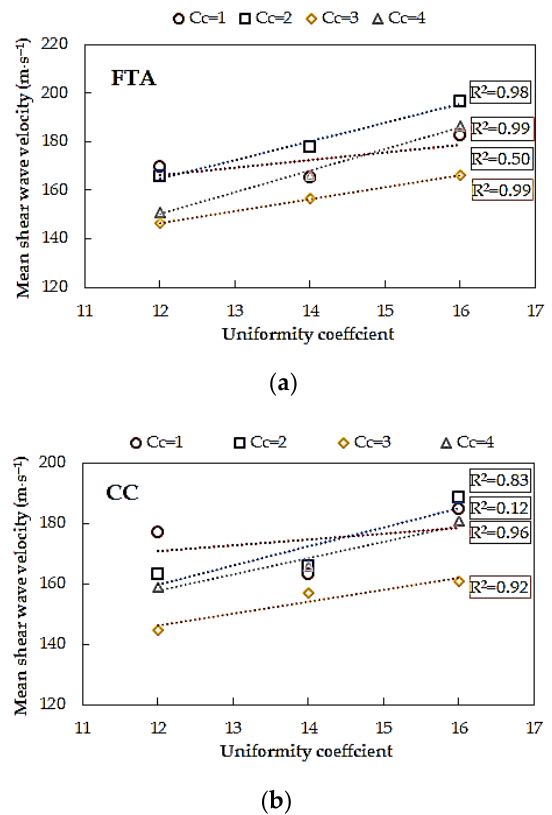
Figure 15. Effect of uniformity coefficient (C U ) on mean shear wave velocity for sands of the same coefficient of curvature ( C C ) from: ( a ) first time of arrival method and ( b ) cross-correlation method.